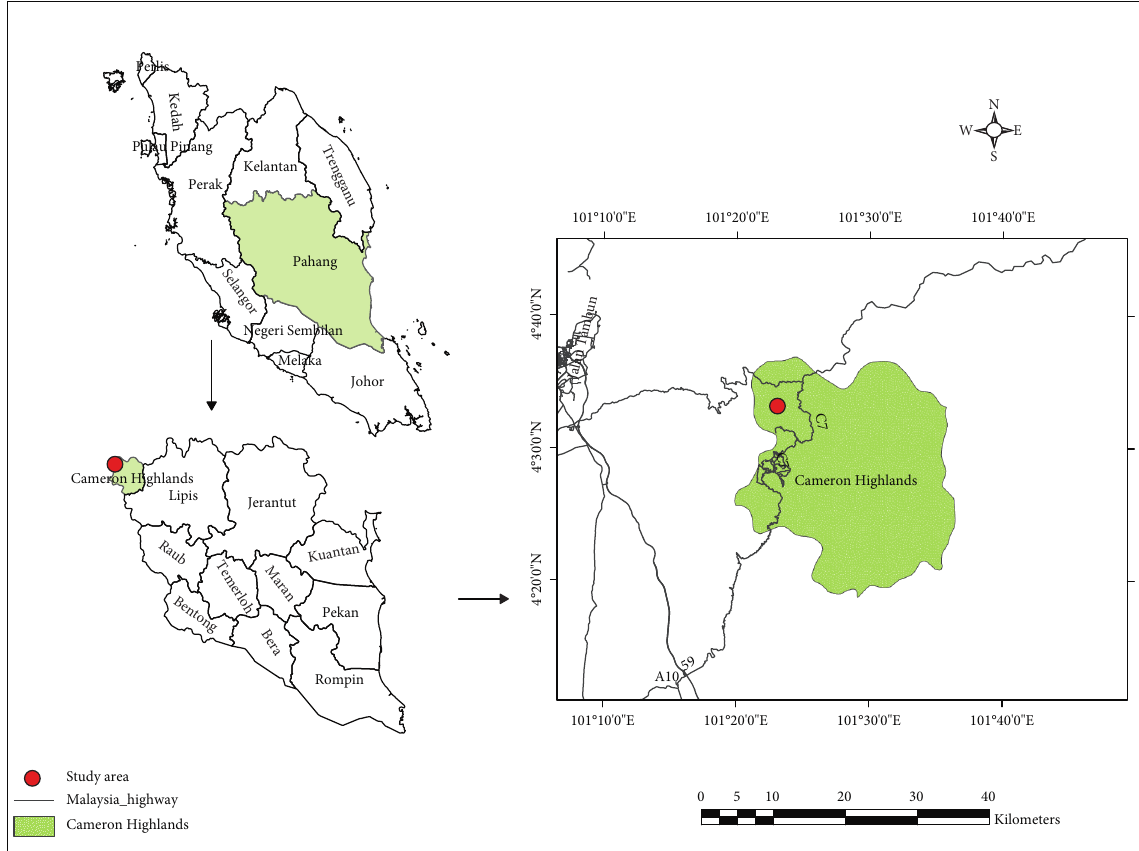
Figure 1: Study site located in Terla Forest Reserve Cameron Highlands, Pahang,